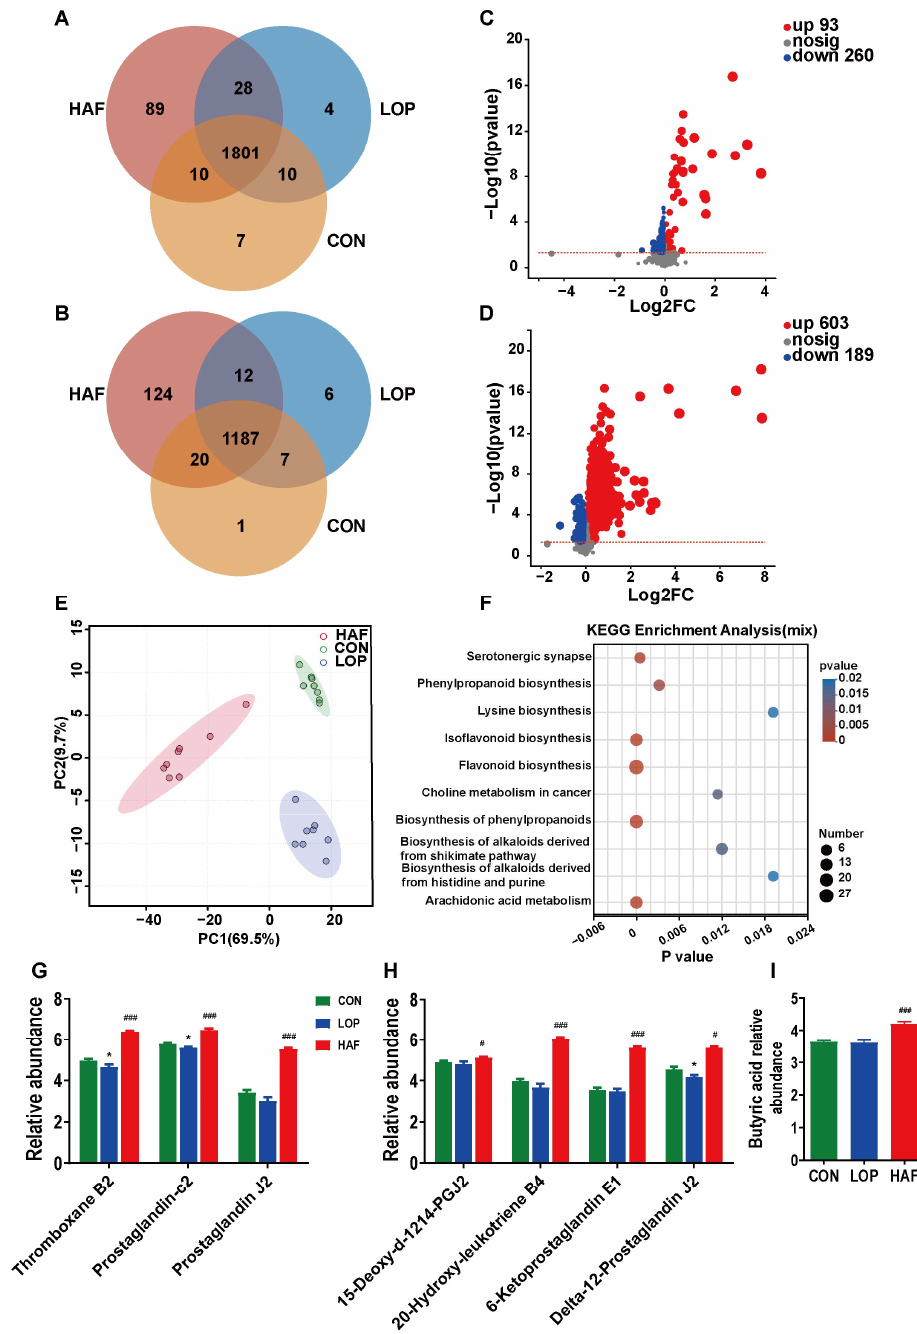
Figure 4. HAF changes the composition of loperamide-induced gut metabolites. Differential metabo- lites in the Venn diagram based on ( A ) cation detection and ( B ) anion detection. ( C ) Volcano map based on the LOP and CON groups. ( D ) Volcano map based on the LOP and HAF groups. ( E ) PCoA (principal coordinate analysis) based on all identified metabolites. ( F ) KEGG enrichment analysis. ( G , H ) Relative abundances of gut metabolites at the serotonergic synapse and arachidonic acid metabolism, respectively, which were significantly affected by loperamide or ATTF. ( I ) Relative abundances of butyric acid. The data are expressed as the means ± SEMs ( n = 6). *, compared with the CON group; #, ###, compared with the LOP group. *, p < 0.05; #, p < 0.05; ###, p < 0.001. Log2FC, multiple change value of the expression difference of metabolites between the two groups; − Log10( p value), statistical test value of the difference in the expression of metabolites. The higher the value, the more significant the expression difference. p < 0.05, n = 8 in each